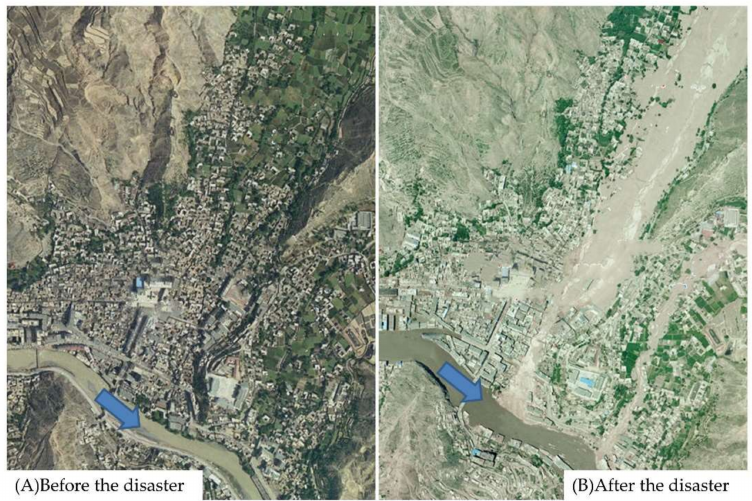
Figure 5. Satellite images of the barrier lake before and after the disaster: ( A ) Before the disaster; ( B ) after the disaster (photograph credit: National Geomatics Center of